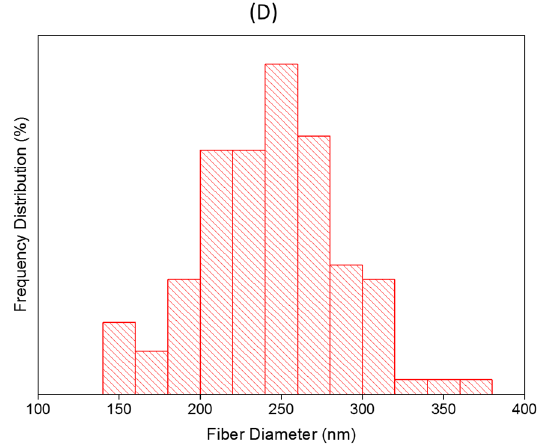
Figure 3. Scanning electron microscopy (SEM) images showing the morphology of: ( A ) drug-loaded ODF as a flat surface, ( B ) drug-loaded nanofibers prepared with no addition of ethanol showing a smooth, un-beaded, and un-porous, but flattened fibrous network, and ( C ) drug-loaded nanofibers prepared by the addition of 10% v / v ethanol showing a smooth, un-beaded, and un-porous fibrous network. ( D ) Nanofibers fibers size distribution of the drug-loaded nanofibers measured from 100 different nanofibers.